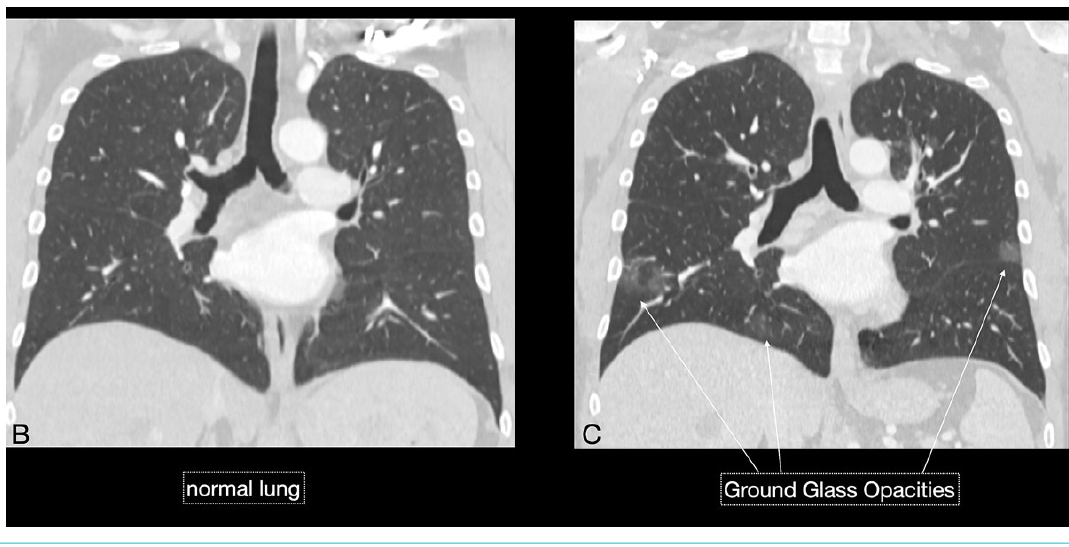
Figure 6 BC: A prior chest computed tomography (CT) (B) compared with the current chest CT (C) demonstrated development of small foci of bilateral ground glass opacities, supporting the clinical suspicion of COVID-19. Mini-bronchoalveolar lavage (BAL) was consequently per- formed and confirmed SARS-Cov-2 virus in BAL fluid.